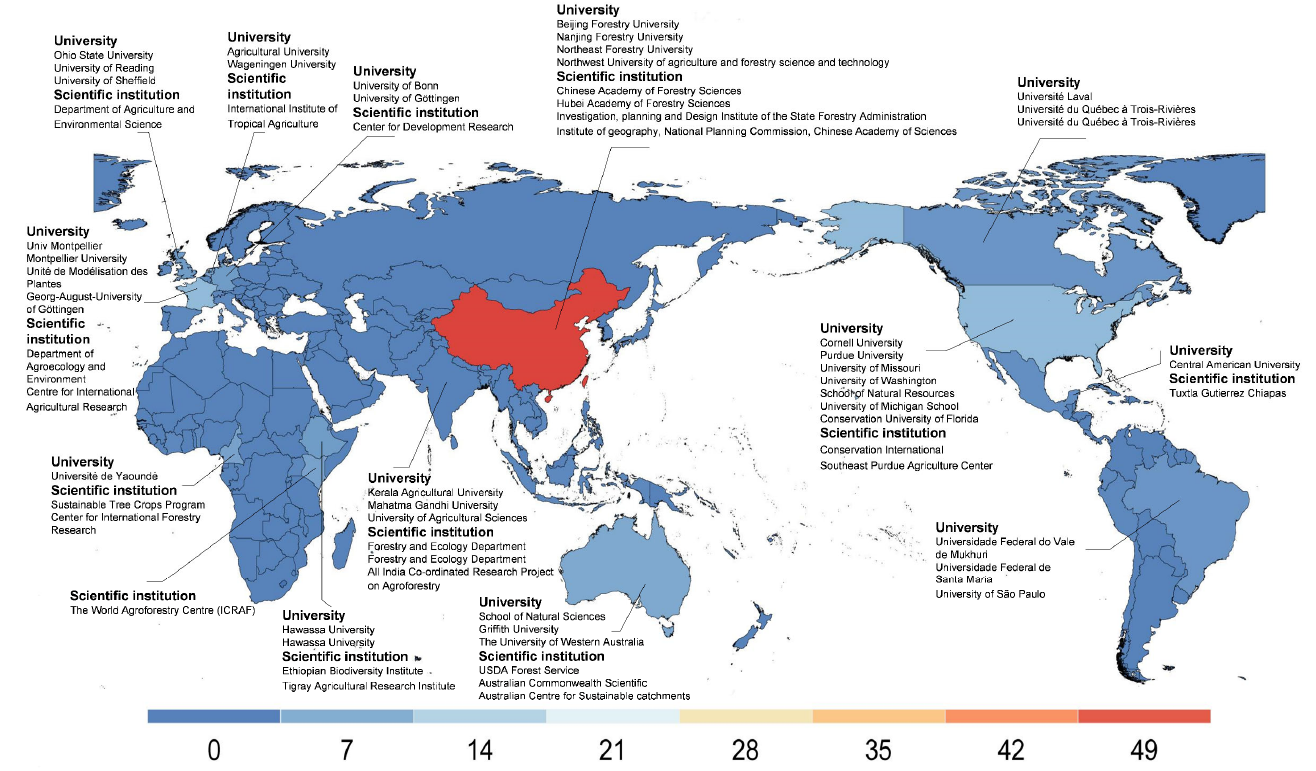
Figure 4. Distribution of countries and institutions studied in the literature. The different color bands and numbers at the bottom indicate the number of publications; the redder the color the higher the number of publications.